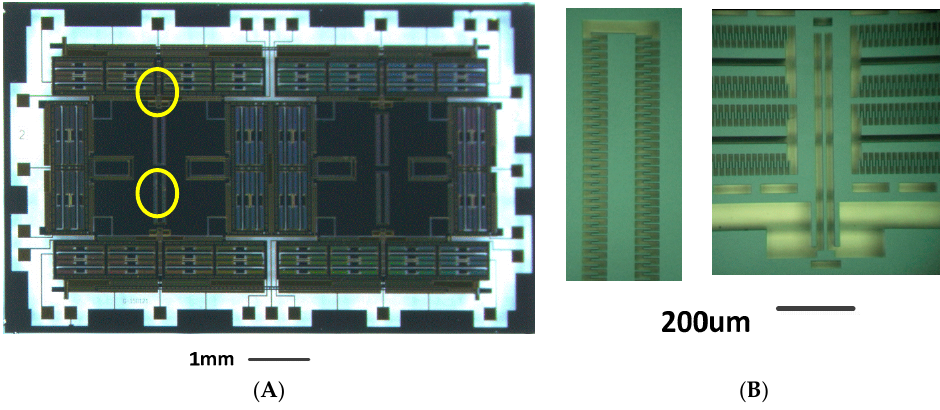
Figure 8. Picture of the structure chip of DDMG. ( A ) Overall structure chip; ( B ) Partial view of the structure chip.